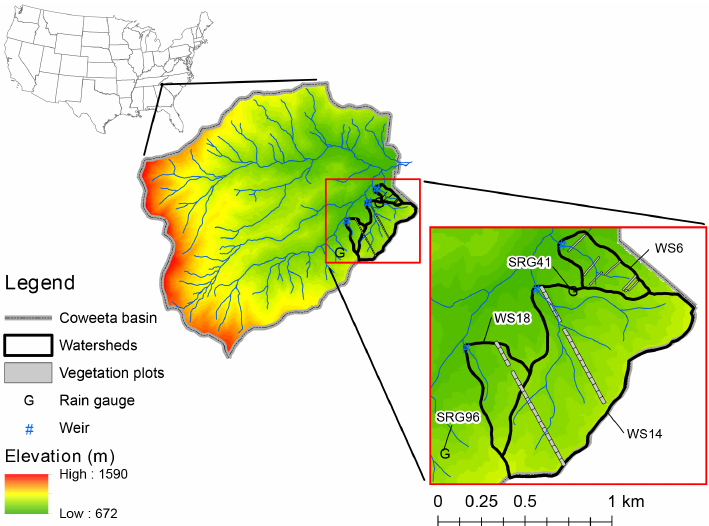
Figure 1. Map of the Coweeta Basin with treated WS6 and reference (WS14, WS18) watersheds with rain gauges, weirs, and vegetation plots.